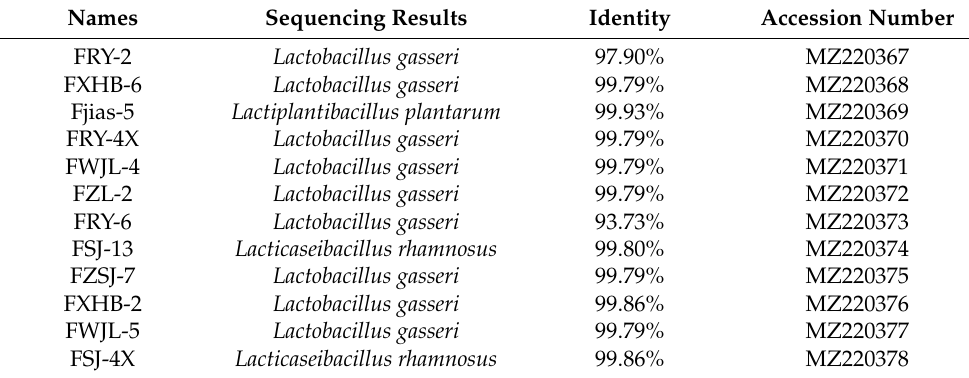
Table 4. 16S rRNA sequencing of candidate probiotics based on the percentage similarity of the sequence found in the GenBank database.